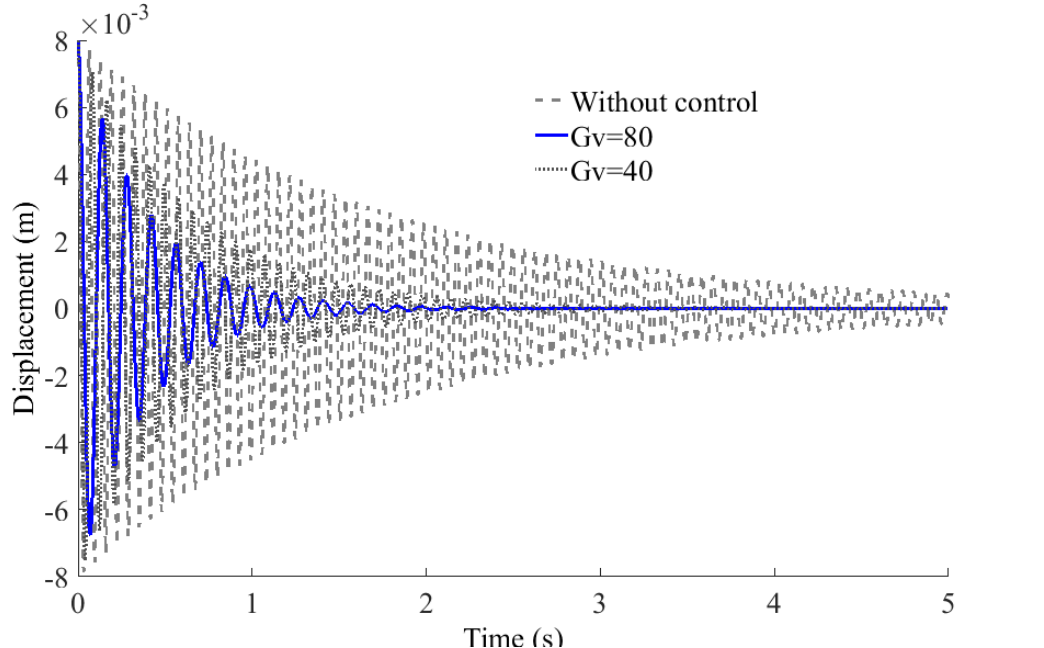
Fig. 6 Tip deflection of clamped-free beam with and without